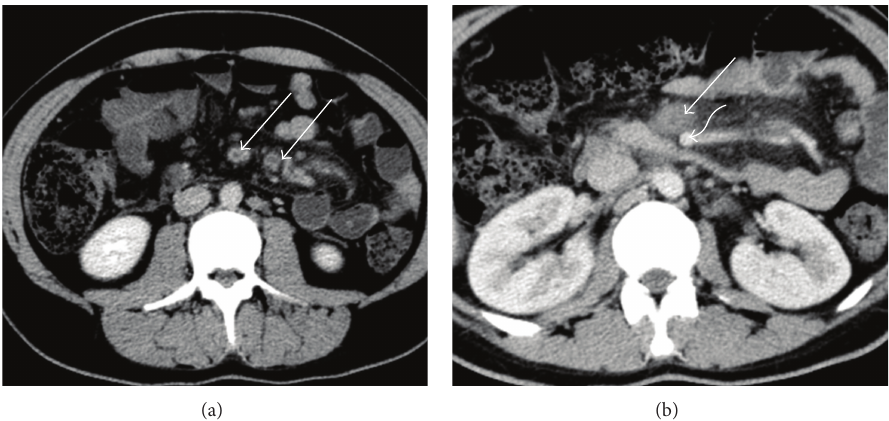
Figure 2: Axial contrast-enhanced CT images acquired at the level of the small-bowel mesentery root show nonenhancing low-attenuation thrombi within the lumen of the superior mesenteric vein tributaries (a) and superior mesenteric vein (b). In (b), the normal superior mesen teric artery is identified (curved arrow).